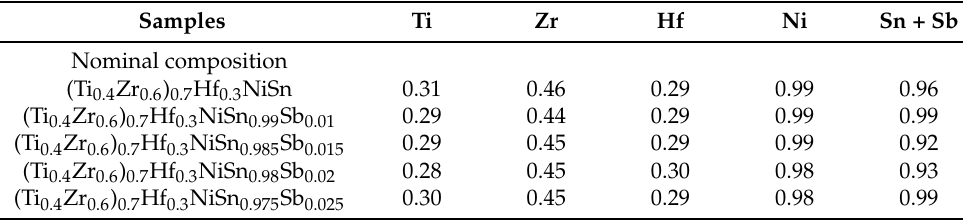
Table 2. EDS analysis of the Sb doped (Ti 0.4 Zr 0.6 ) 0.7 Hf 0.3 NiSn